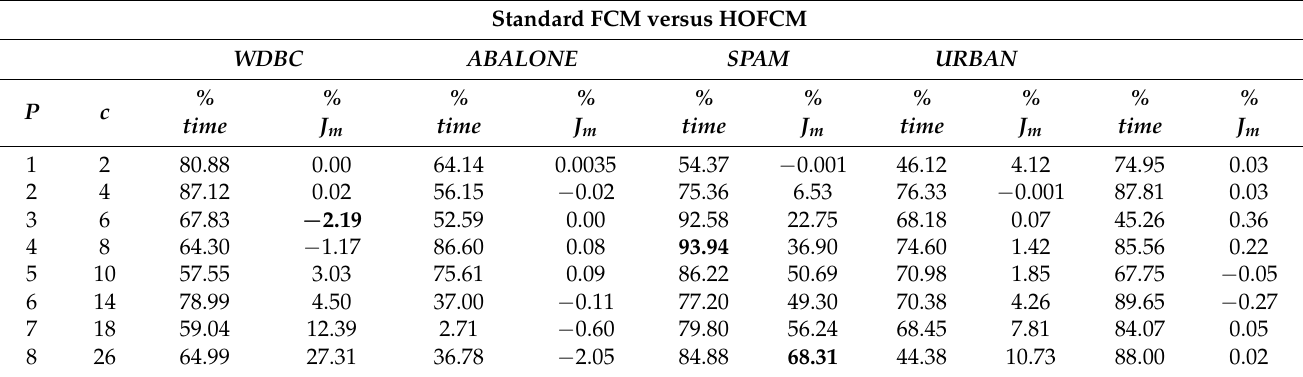
Table 2. Average percentages of time reduction and value of the objective function in Experiment I. Standard FCM versus HOFCM WDBC ABALONE SPAM